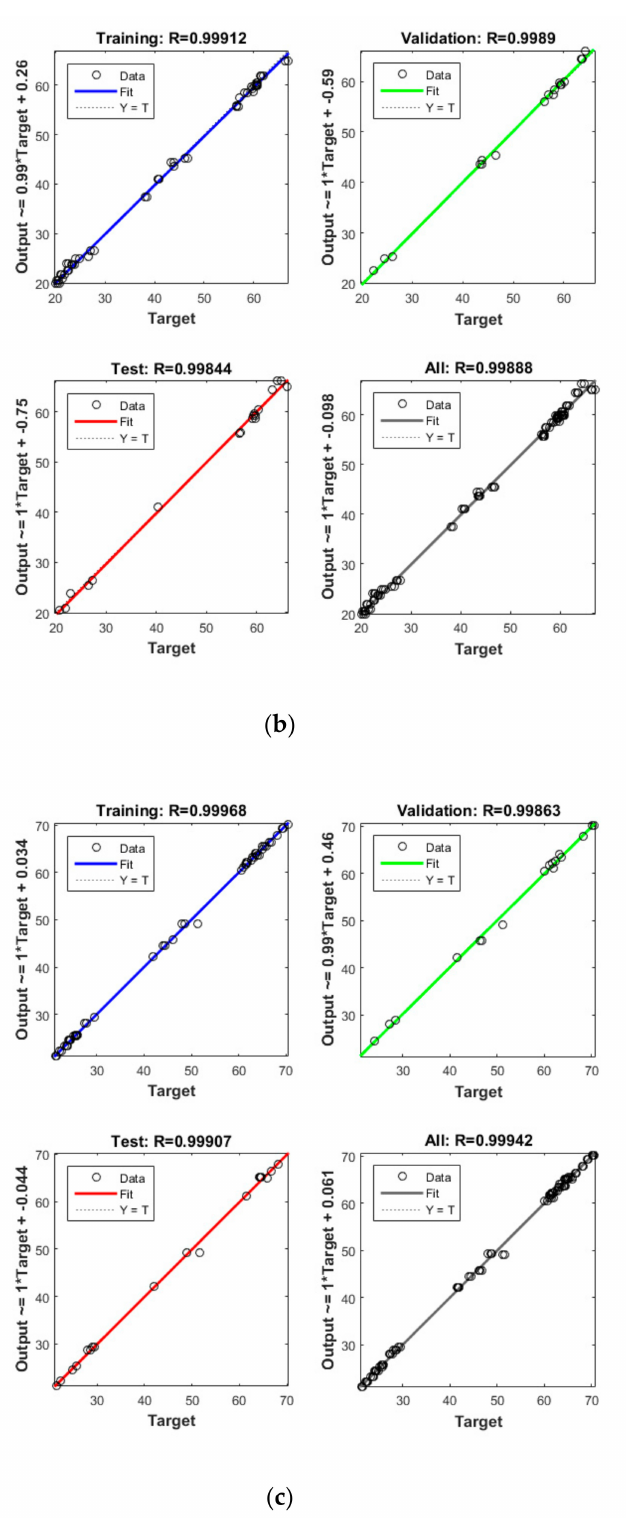
Figure 5. Model prediction versus experimental values for the removal of CBZ ( a ), SMT ( b ) and TRA ( c ) by the second